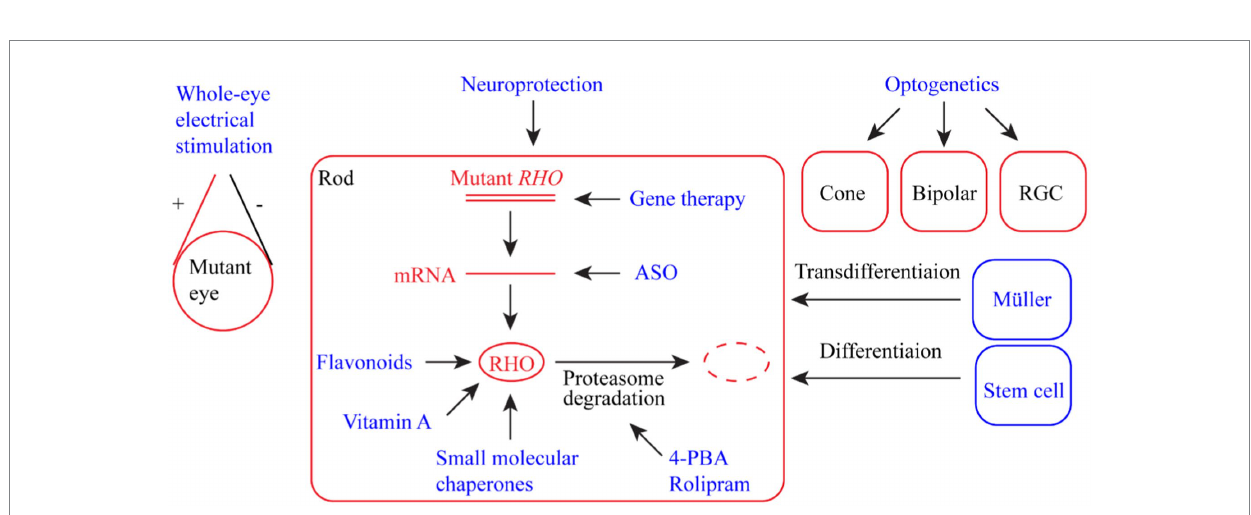
FIGURE 2 Summary of therapeutic strategies for retinal dystrophy (RD) associated with rhodopsin mutations. The strategies include whole-eye electric stimulation, pharmacological therapy (flavonoids, vitamin A, small molecular chaperones, 4-PBA (4-phenyl butyric acid), and rolipram), ASO (antisense oligonucleotide) therapy, gene therapy, neuroprotection, optogenetic therapy, and stem cell therapy (including photoreceptor regeneration from Müller